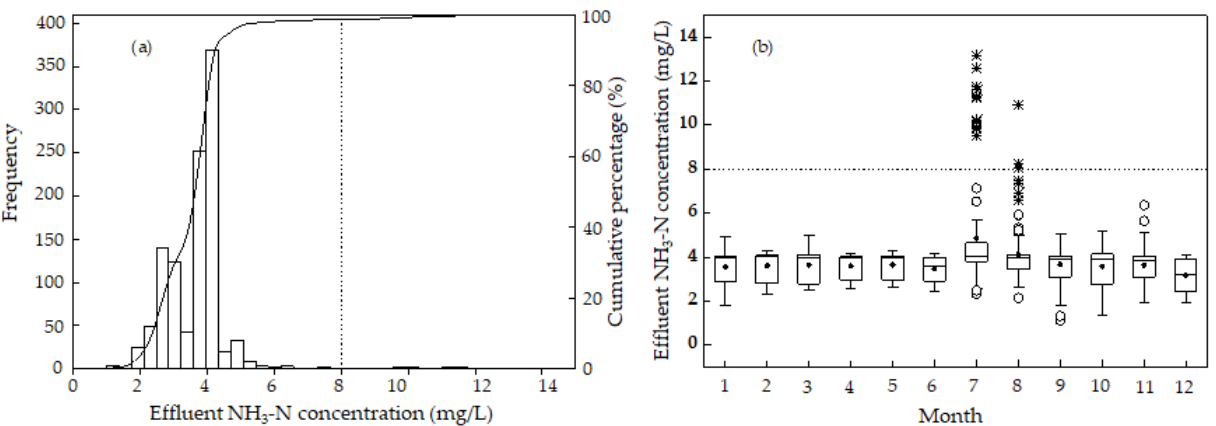
Figure 6. ( a ) Probability distribution and ( b ) monthly distribution of effluent NH 3 -N concentration. The solid circle ( • ) represents the average. Outliers are marked by a hollow point ( ◦ ) and extreme points are marked by an asterisk (*).